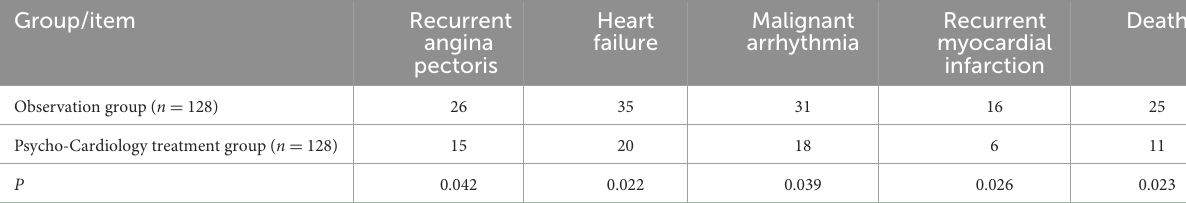
TABLE 4 Inter-group comparison of adverse cardiovascular events before and after treatment ( n , %).